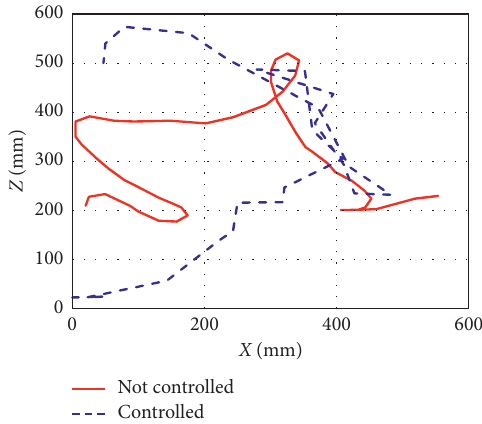
Figure 17: Flight trajectory of two flapping-wing drones.